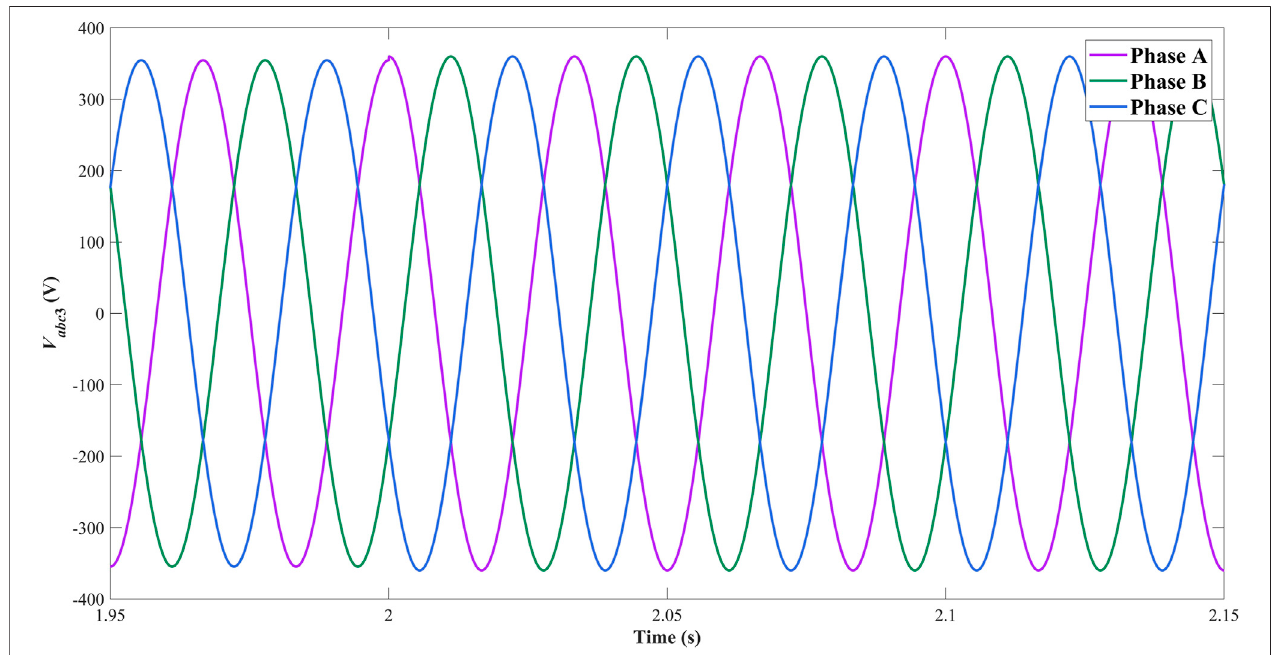
FIGURE 11 | Three-phase waveforms of PCC3